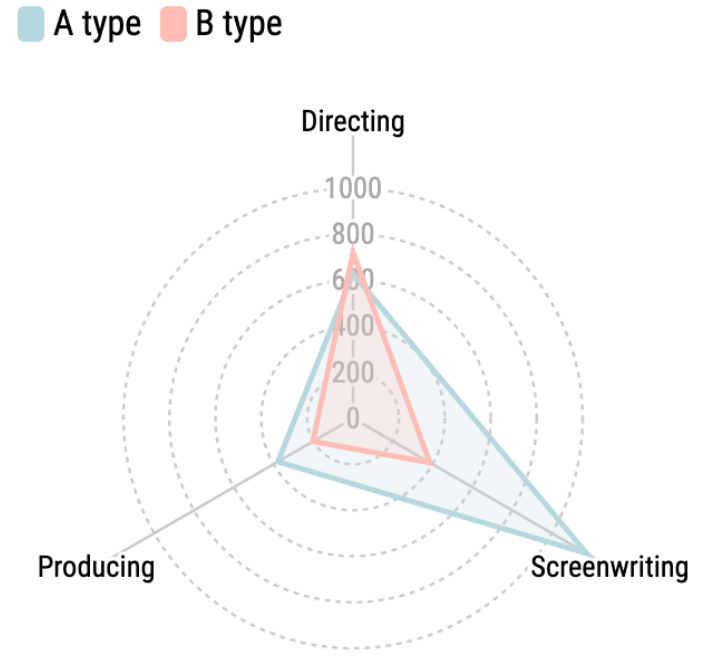
Figure 5. Overall view of professions by type in the Yeşilçam industry